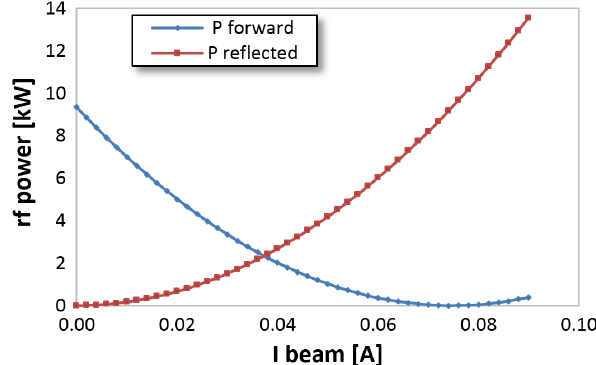
FIG. 7. Enlarged view of the JLab rf window with the pumping port and eccentric knobs (left, shown in yellow) and FPC coupling slot on the cavity with FPC tuners (right, shown in gray).